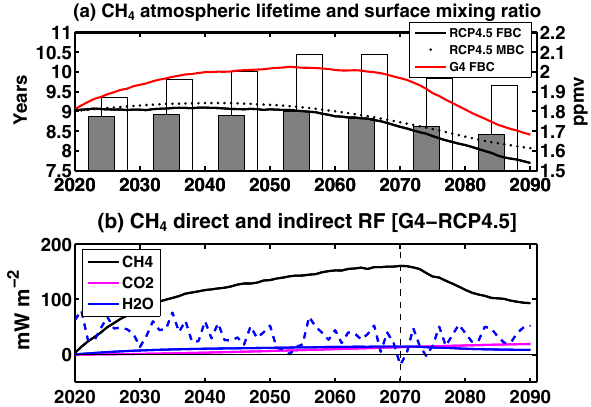
Figure 13. (a) Time series of CH 4 global mean atmospheric lifetime (years, left scale, bars) calculated in the ULAQ-CCM FBC case (ex- periment b of Table 1), with bars referring to decadal averages (gray for RCP4.5 and white for G4). Superimposed are globally averaged CH 4 surface mixing ratios (ppmv, right scale) for the correspond- ing RCP4.5 and G4 simulations (black solid and red curves, respec- tively). The dotted curve shows globally averaged CH 4 surface mix- ing ratios for the RCP4.5 MBC case (experiment a in Table 1), i.e., using prescribed fixed mixing ratios at the surface (Eyring et al., 2013). (b) Time series of G4-RCP4.5 radiative forcing of CH 4 (mWm − 2 ). Black, purple and blue curves show the direct and in- direct effects (purple and blue curves are for CO 2 and stratospheric H 2 O from CH 4 oxidation, respectively). Dashed blue curve is for stratospheric H 2 O changes resulting from G4-RCP4.5 temperature anomalies at the tropopause tropical layer